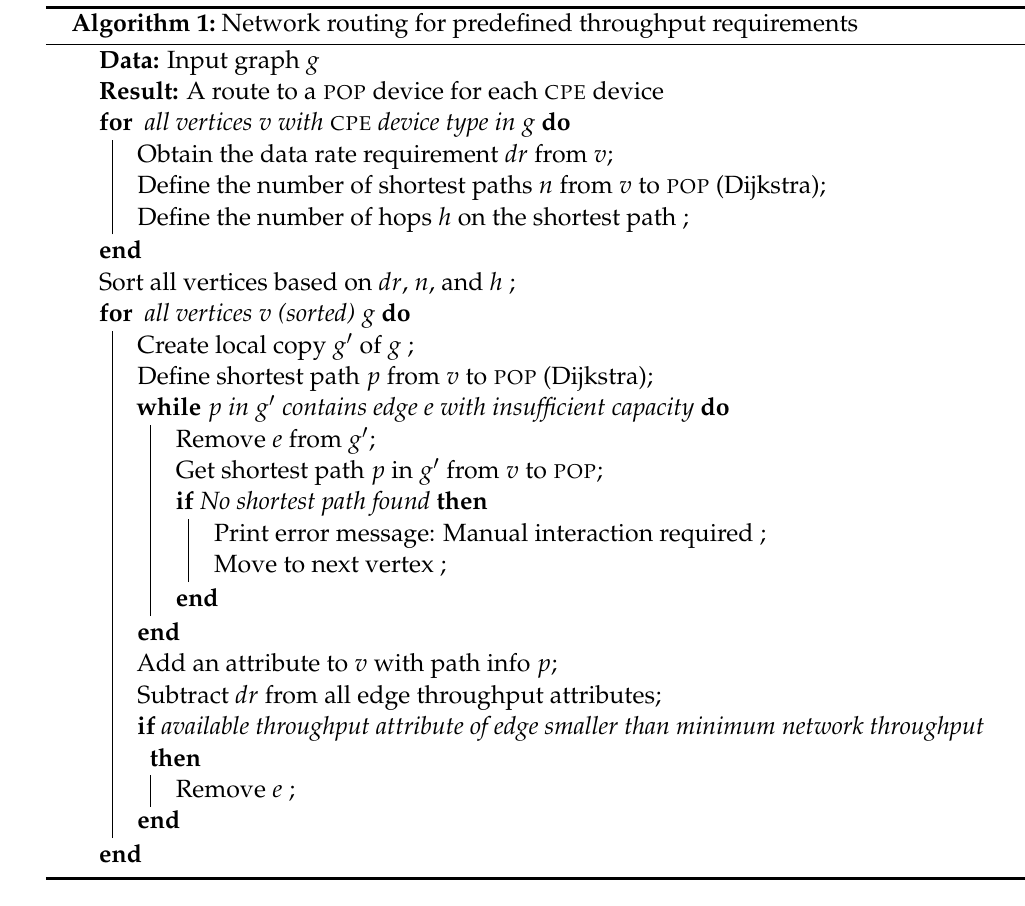
Algorithm 1: Network routing for predefined throughput requirements Data: Input graph